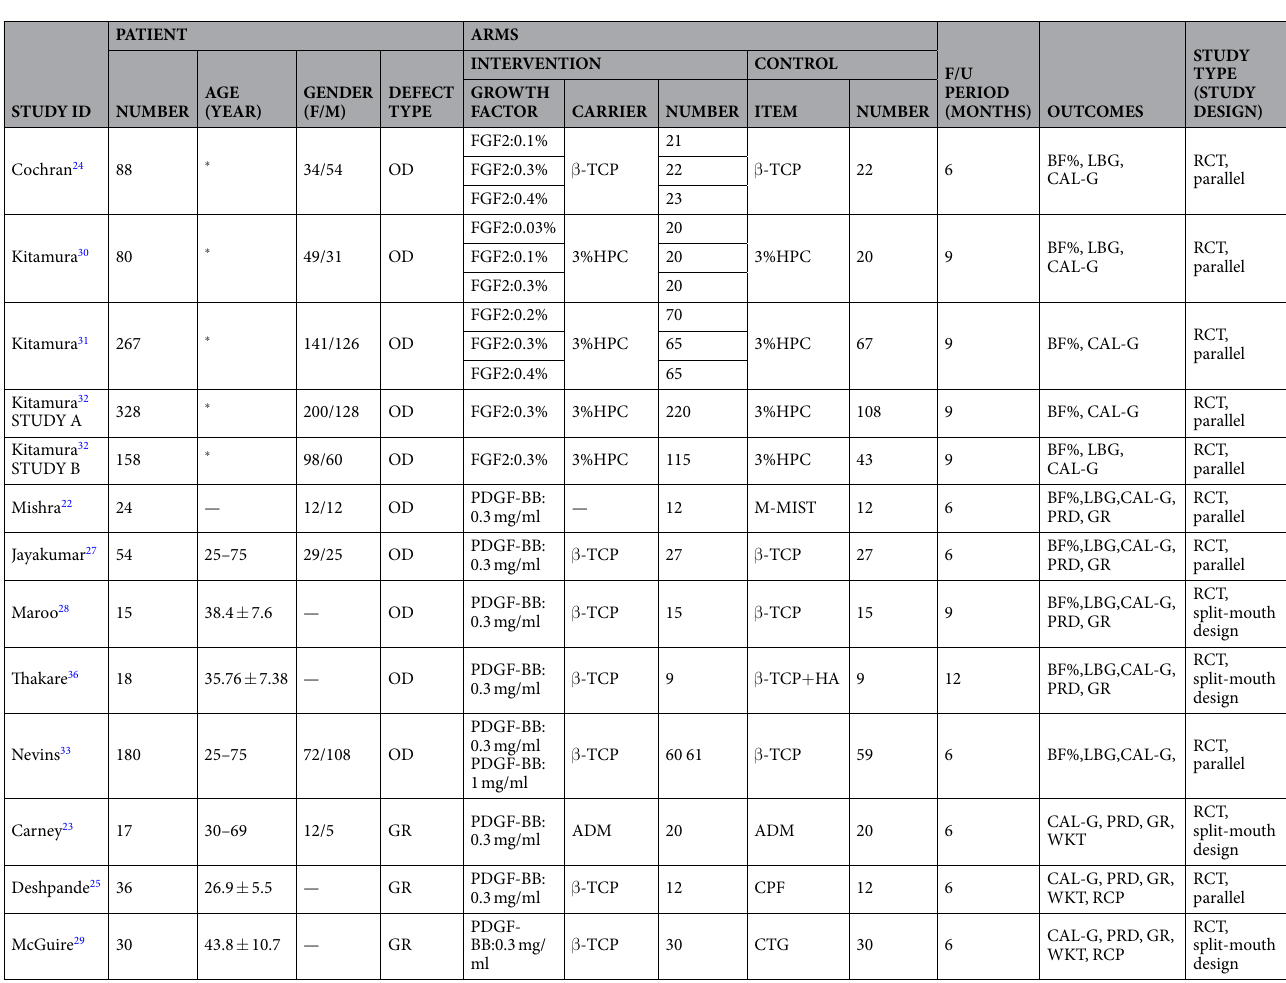
Table 1. Characteristics of included studies. * Age range difffered in each group (raw data shown in